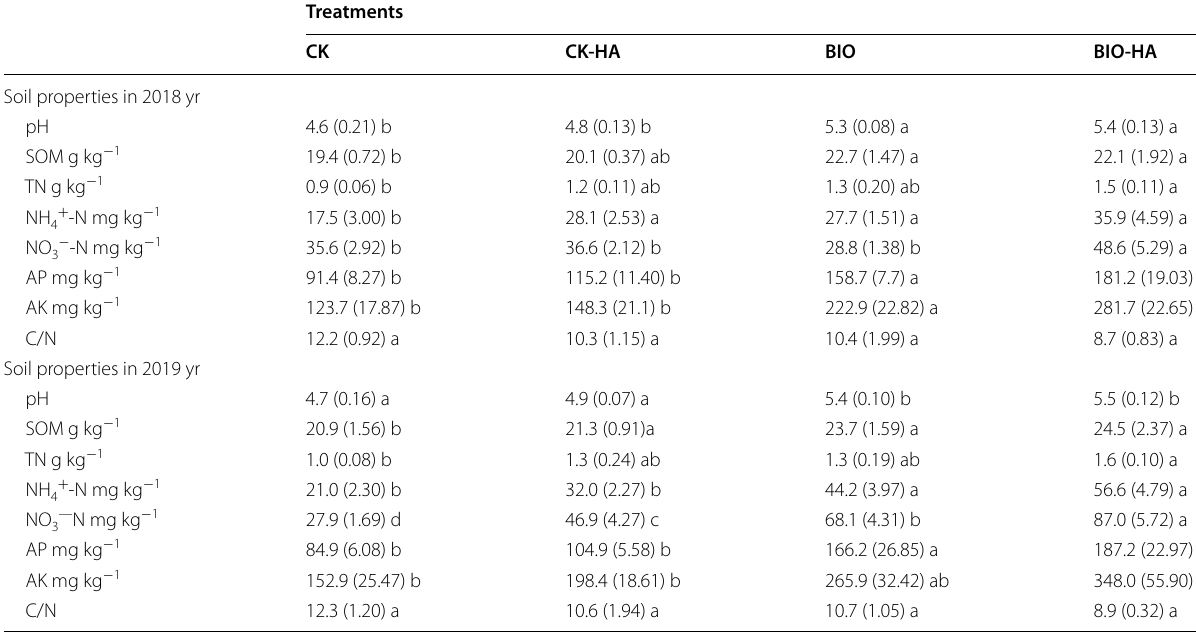
CK conventional fertilization, HA humic acid amendment, CK-HA conventional fertilization combined with HA, BIO bio-organic fertilizer, BIO-HA mixed application of BIO and HA, SOC soil organic carbon, TN total nitrogen, NH 4 + -N ammonium nitrogen, NO 3 − -N nitrate-nitrogen, AP available phosphorus, AK available potassium, C/N ration of soil carbon content to nitrogen content Each value represents the mean (n 6), and standard error values are indicated with = ± Different letters indicate significant difference ( P < 0.05 ) in every column among the four treatments as determined by Fisher’s least significant difference test (LSD) at α =